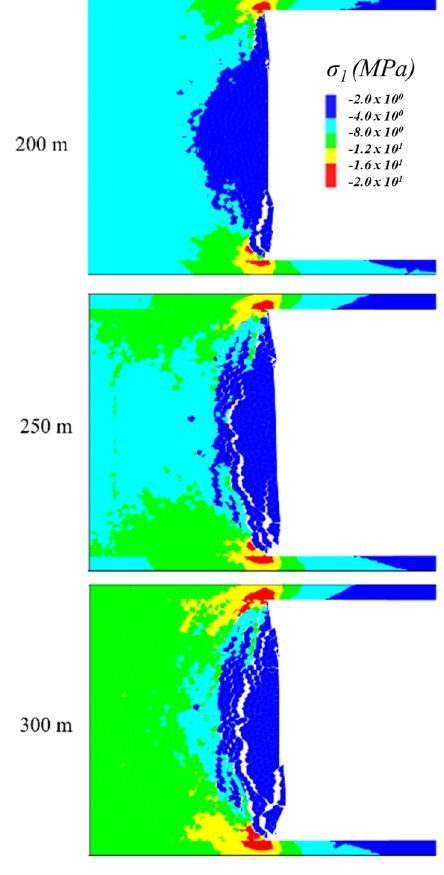
Figure 10. Major principal stress distribution in the rib during fracturing process as the strength of the coal mass is reduced by 1.80.